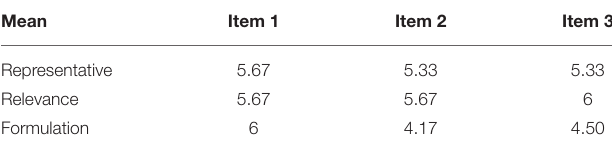
TABLE 5 | Mean (students-pre).